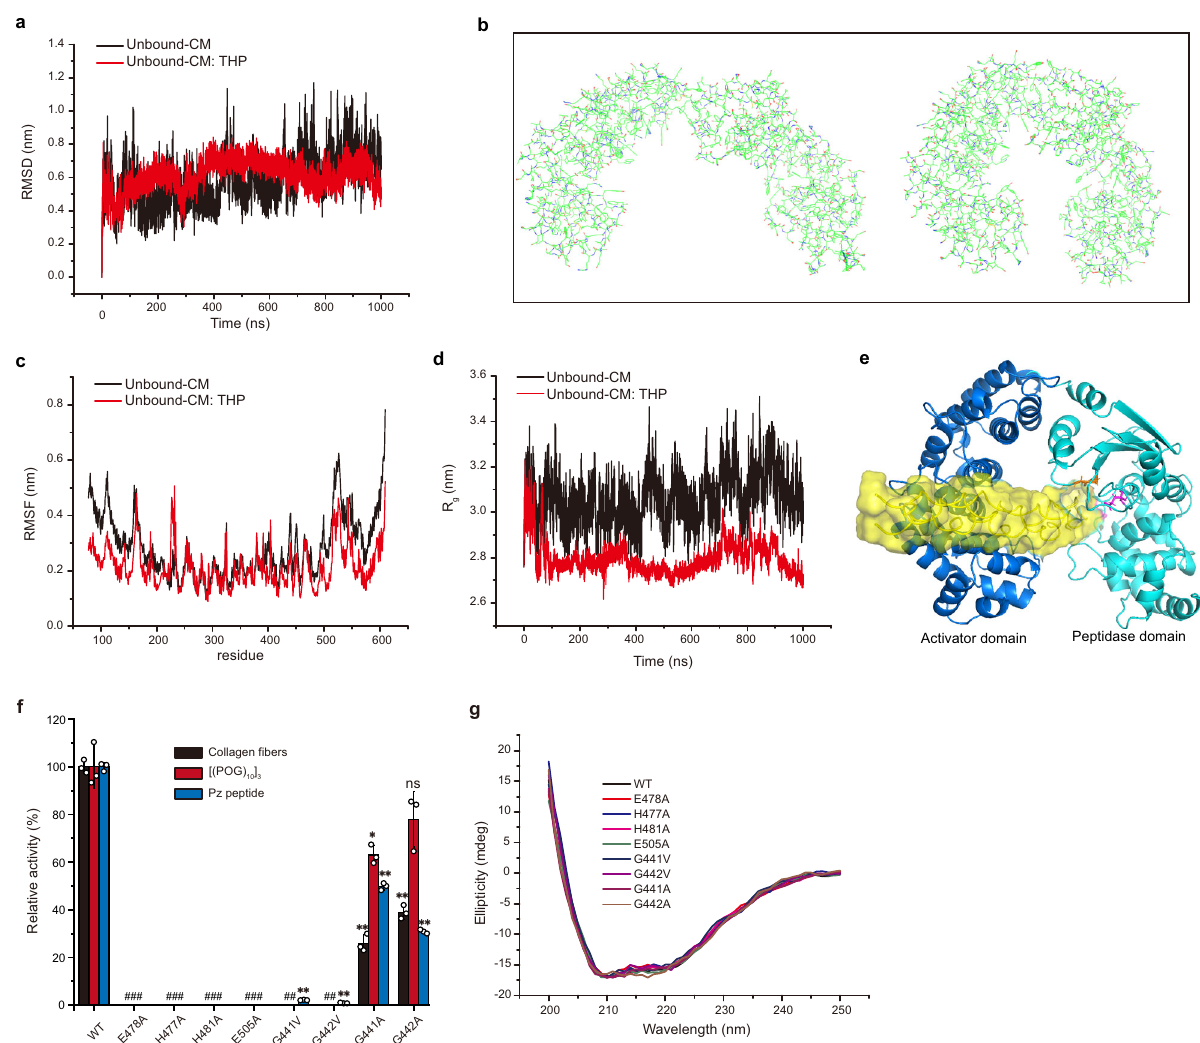
Fig. 3 The catalytic mechanism of CM for triple-helical collagen. a RMSD of the backbone atoms of the unbound-CM and unbound-CM: THP complex structures. b Analysis of the conformational change of the fi rst principal component in the unbound-CM MDS. c RMSF of the CM residues in the MDS of the unbound-CM and unbound-CM: THP structures. d Radius of gyration ( R g ) of the unbound-CM and unbound-CM: THP structures over simulated time. e The most populated cluster during the MDS of the unbound-CM: THP binary complex. The catalytic Glu478 (magenta) and double-Gly motif (orange) are labeled. The THP is indicated as surface and colored in yellow. f The activities of VhaC (WT) and its mutants towards type I collagen fi bers, [(POG) 10 ] 3 , and Pz peptide. The speci fi c activities of VhaC towards collagen fi bers, [(POG) 10 ] 3 and Pz peptide were taken as 100%. Data shown are mean ± SD ( n = 3 independent experiments). For comparison of the statistical differences between two groups, a two-tailed t -test was used in statistical analysis. * p < 0.01. ** p < 0.001. ns, no signi fi cant difference ( P ≥ 0.01). # The signi fi cance was not compared due to the activity of the enzyme was undetectable. The p -values in all cases were compared with the corresponding wild type, and provided in the source data. g CD spectra of VhaC (WT) and its mutants. The data shown are representatives of triplicate experiments. Source data are provided as a Source Data fi